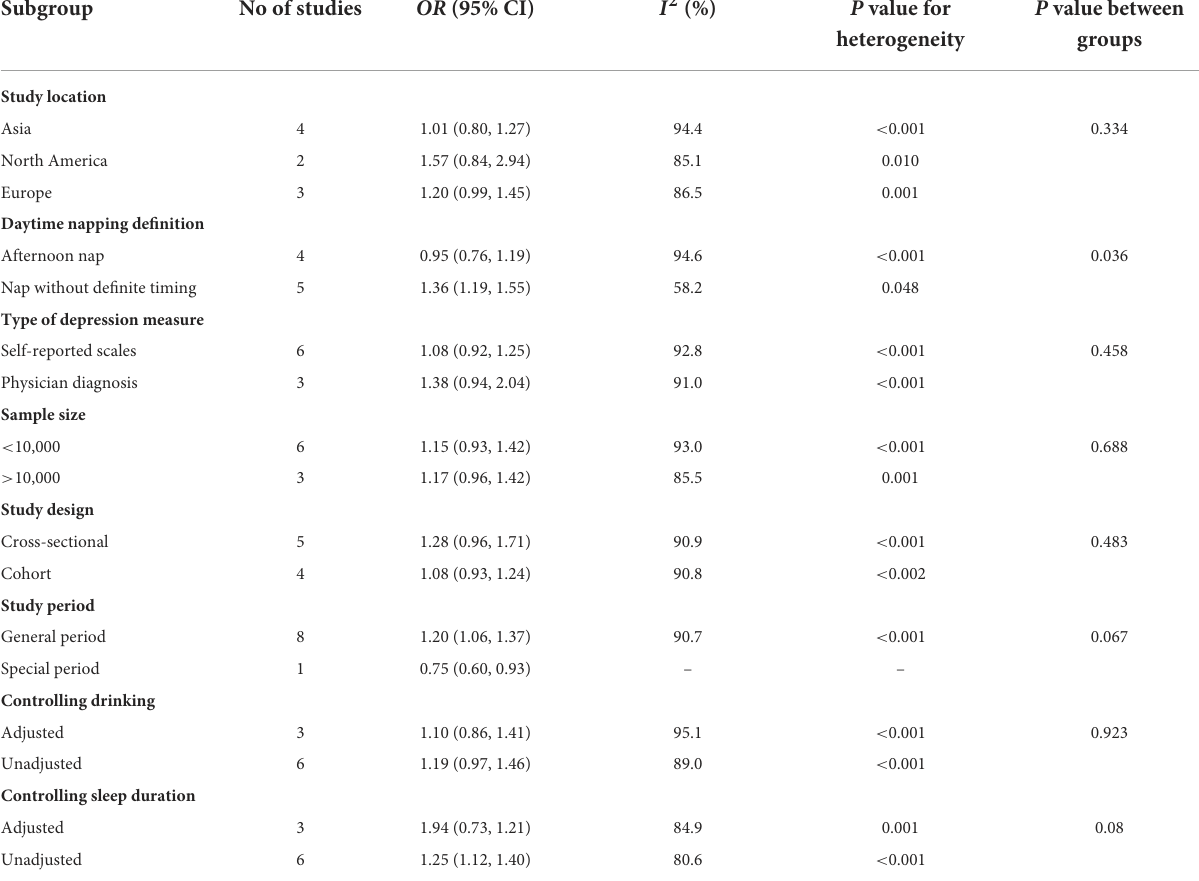
TABLE 4 Subgroup analysis of odd ratios for the association between daytime napping and depression. Subgroup